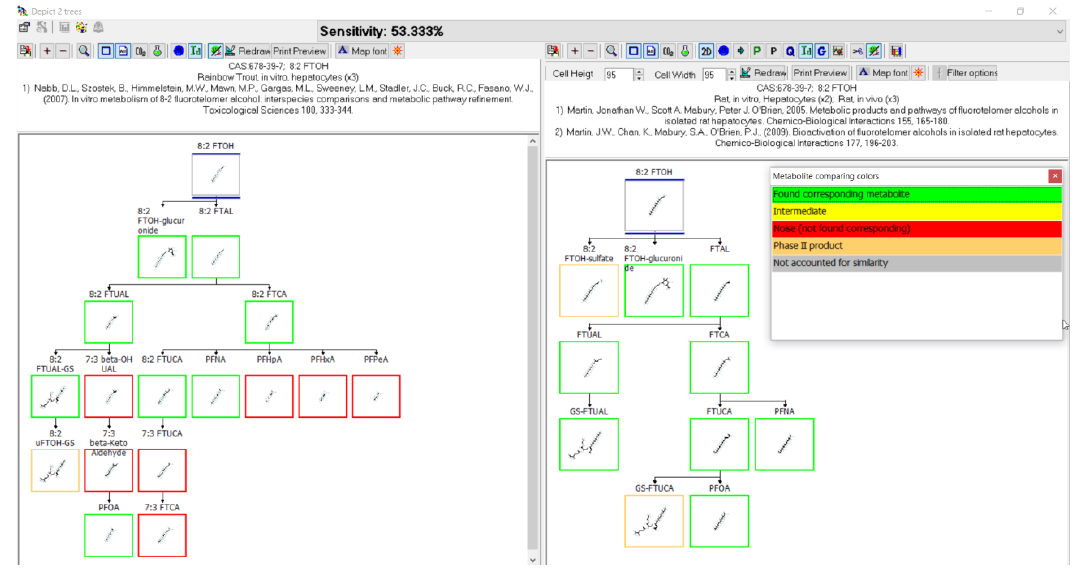
Figure 4. Metabolic map comparison of 8:2 FTOH in ( left ) rainbow trout hepatocytes and ( right ) rat hepatocytes. Metabolites common to both species are indicated by green boxes. Differences in metabolites are indicated by red boxes. Tan boxes indicate phase II conjugates. Sensitivity, in this case 53.333%, is an assessment of the map comparison whereby the number of common metabolites is divided by the total number of metabolites.